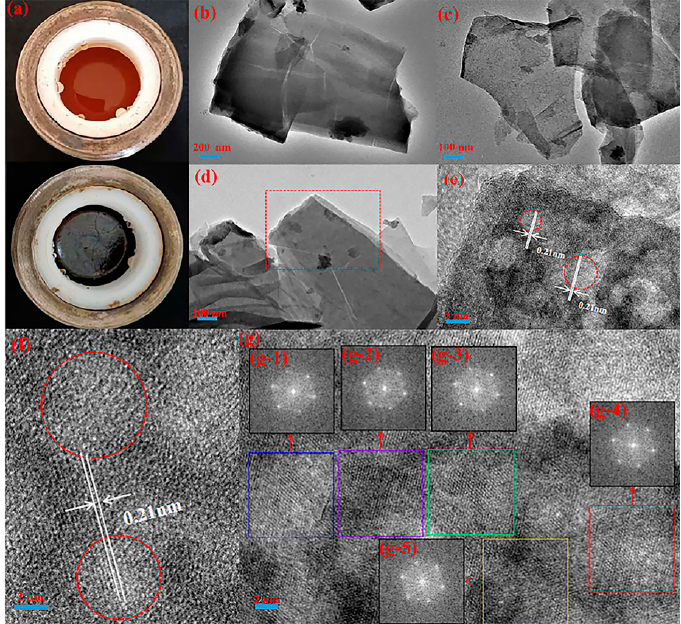
Figure 1. ( a ) Reaction autoclave diagrams of GN-0 and GN-1.5 in the control group; ( b – d ) HRTEM images of GN-1.5 at different magnification; ( e – g ) The lattice structure of the GN-1.5 obtained from HRTEM image; ( e ) the lattice diagram corresponding to the red region in ( d – f ) are the edge and internal lattice diagrams of GN-1.5, respectively; inserts ( g - 1 ), ( g - 2 ), ( g - 3 ), ( g - 4 ), and ( g - 5 ) fast Fourier transform (FFT) patterns of the rectangular region correspond to the blue, purple, green, red, and yellow boxes in ( g ), respectively.